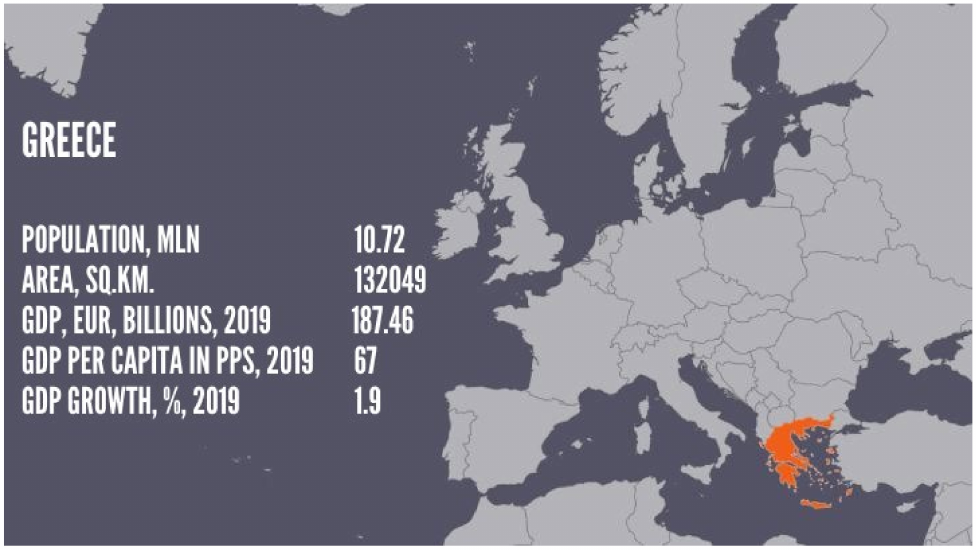
Figure 14. Stylized facts about Greece (designed by the authors, based on [86,99,100]). The Greek electricity system can be divided into interconnected (continental Greece) and autonomous (Greek Islands) [128] or NIIs, which consist of fifty Greek islands in the Aegean Sea (which account for approximately 9% of the total Greek electricity